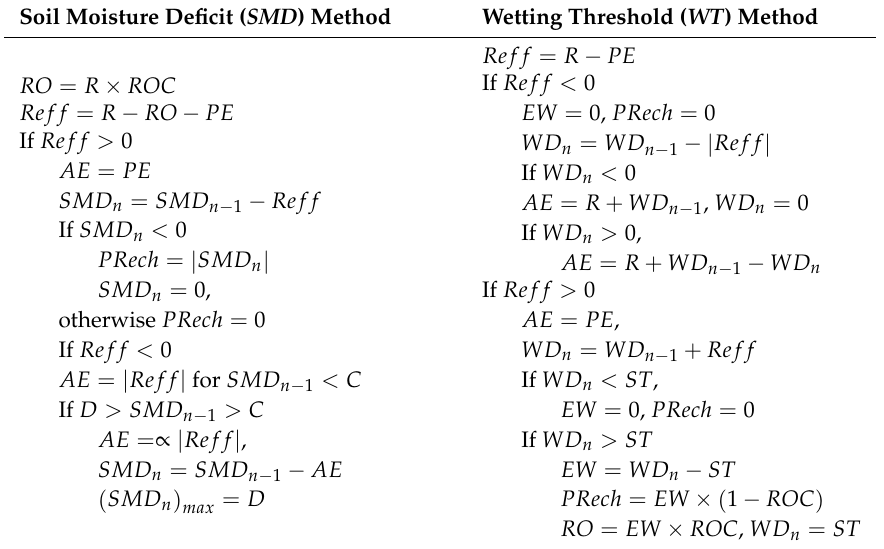
Table 2. Algorithms of the soil moisture deficit ( SMD ) and wetting threshold ( WT )